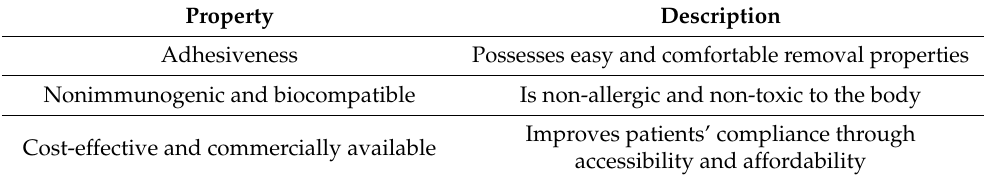
Table 2. Cont. Property Description Adhesiveness Possesses easy and comfortable removal properties Nonimmunogenic and biocompatible Is non-allergic and non-toxic to the body Improves patients’ compliance through Cost-effective and commercially available accessibility and